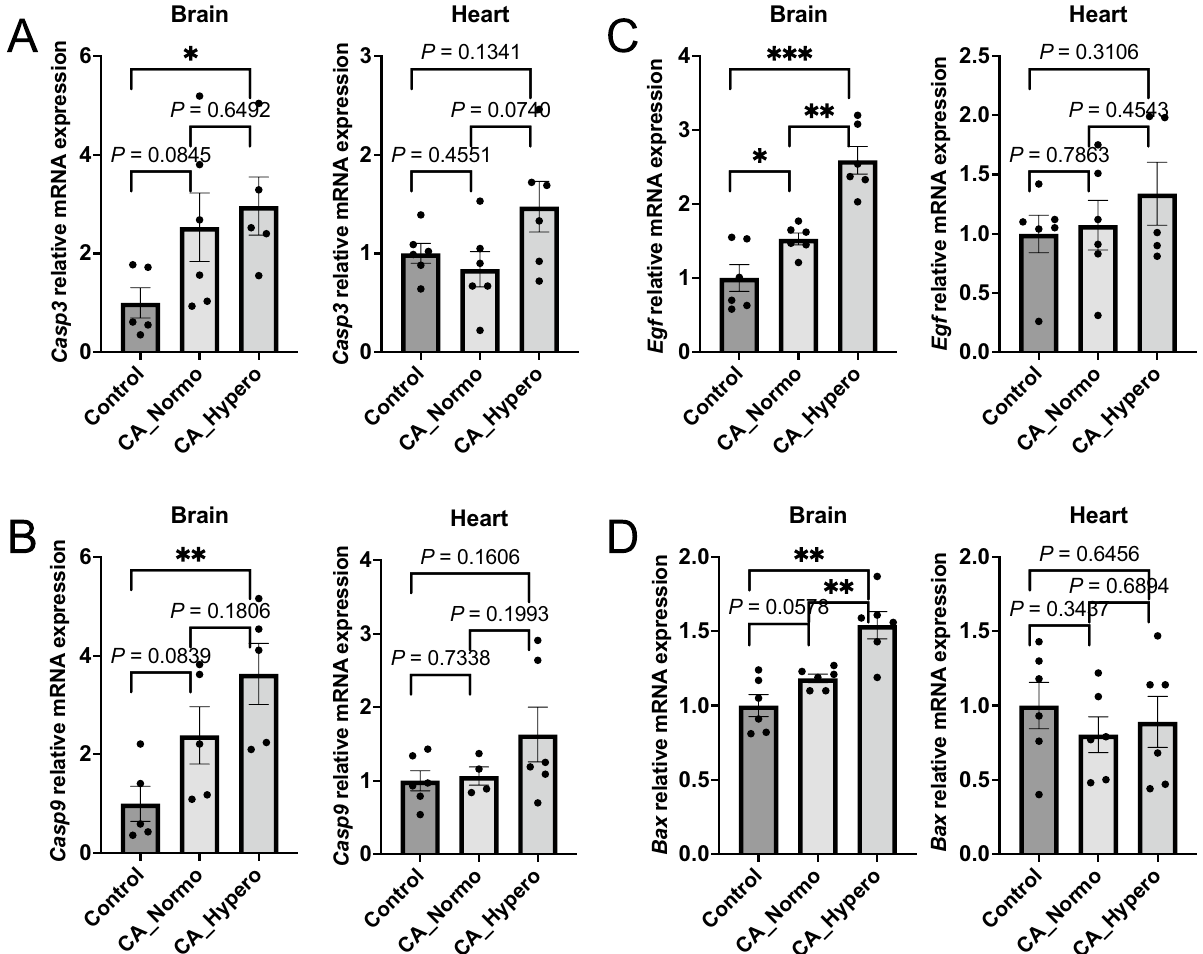
Figure 6. Apoptotic mRNA relative gene expression. Casp3 , Casp9, Egf , Bax . Real time PCR was performed to compare mRNA gene expression. ( A ) Casp3 was upregulated in CA_Hypero group but not in CA_Normo group, though there was no significant difference between the groups in brain. Casp3 was not upregulated after CA in the heart. ( B ) Casp9 was upregulated in CA_Hypero group but not in CA_Normo group, which tended to be attenuated by normoxic therapy in brain. Casp9 was not upregulated after CA in heart. ( C ) Egf was upregulated in CA_Hypero group in brain, which was significantly attenuated by normoxic therapy. Egf was not upregulated after CA in heart. ( D ) Bax was upregulated in CA_Hypero group in brain, which was significantly attenuated by normoxic therapy. Bax was not upregulated after CA in heart. N = 4–6. * P < 0.05, ** P < 0.01, *** P < 0.001.